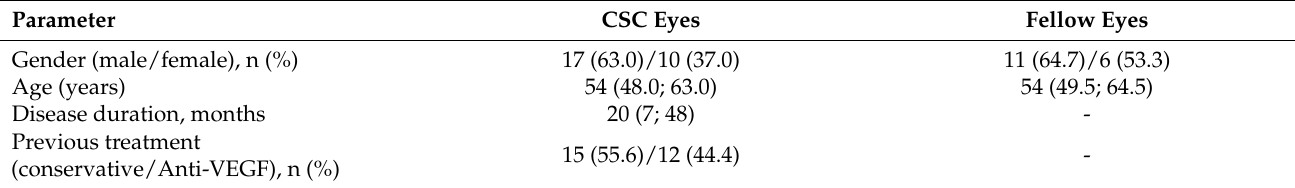
Table 1. Demographic and clinical characteristics of enrolled CSC patients and